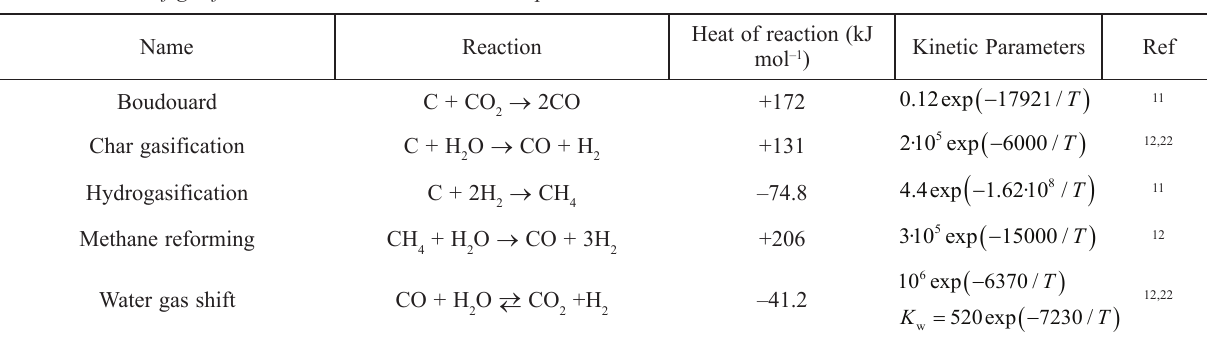
Table 1 – List of gasification reactions and their kinetic parameters